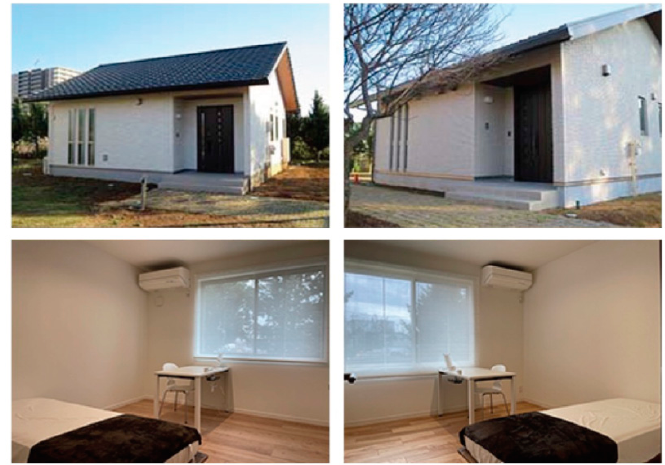
Figure 1. Evaluation tests were conducted in the LHs. Upper left: exterior of LH-A (typical Japanese wooden house), bottom left: bedroom of LH-A, upper right: exterior of LH-B (light-gage steel-structured house), bottom right: bedroom of LH-B.